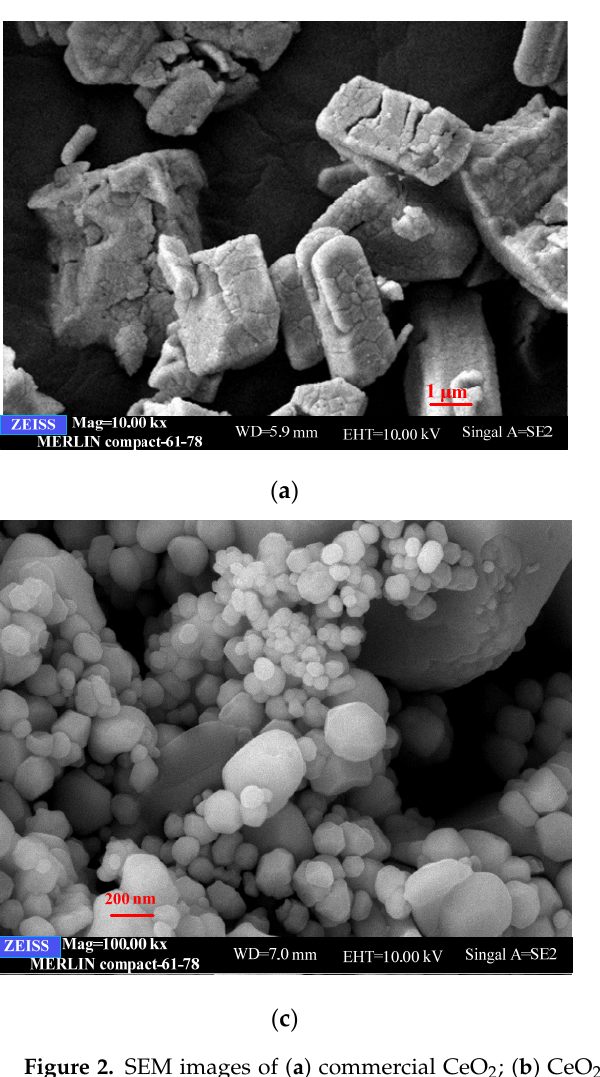
Figure 1. XRD patterns for the prepared CeO 2 -NiO and CeO 2 -Na-NiO.